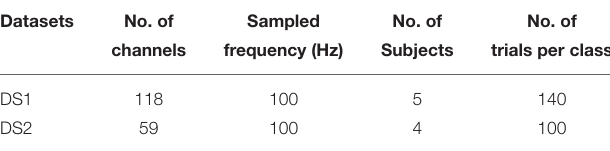
TABLE 2 | OFB of channels with non-zero weights on subject ay of